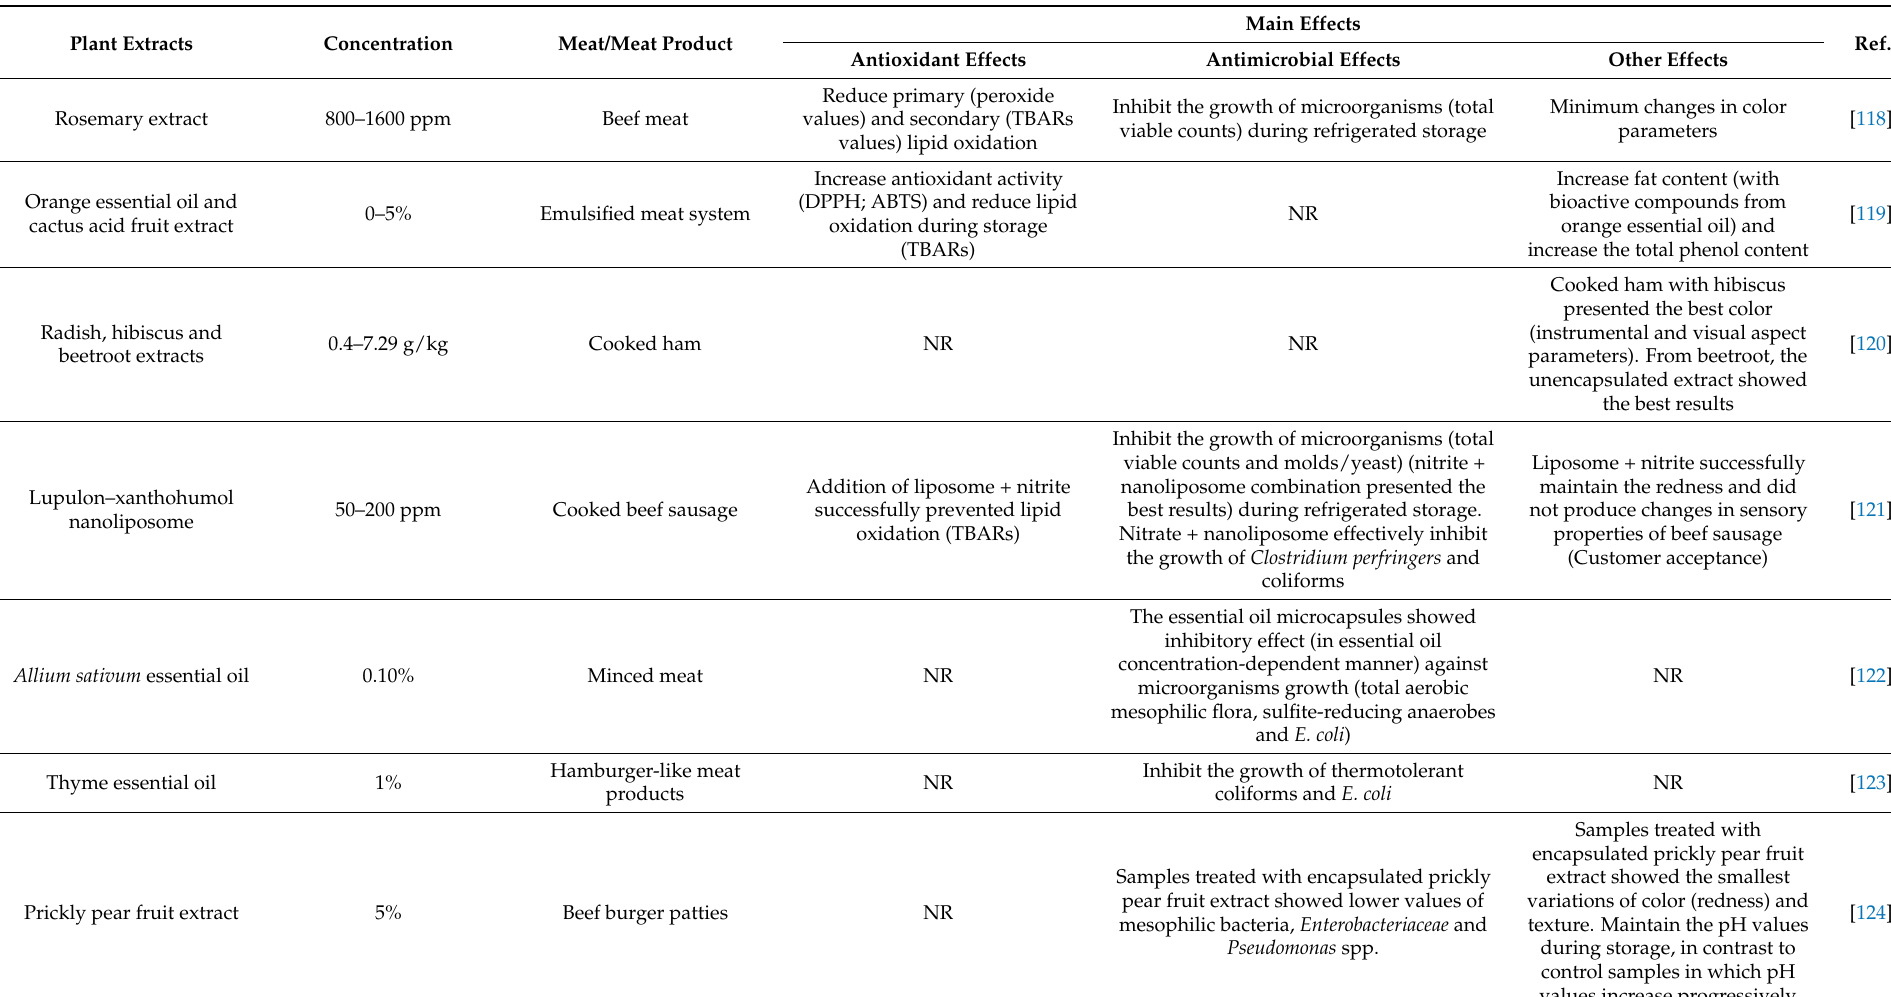
Table 2. Effects of the application of encapsulated plant-based active ingredients in meat